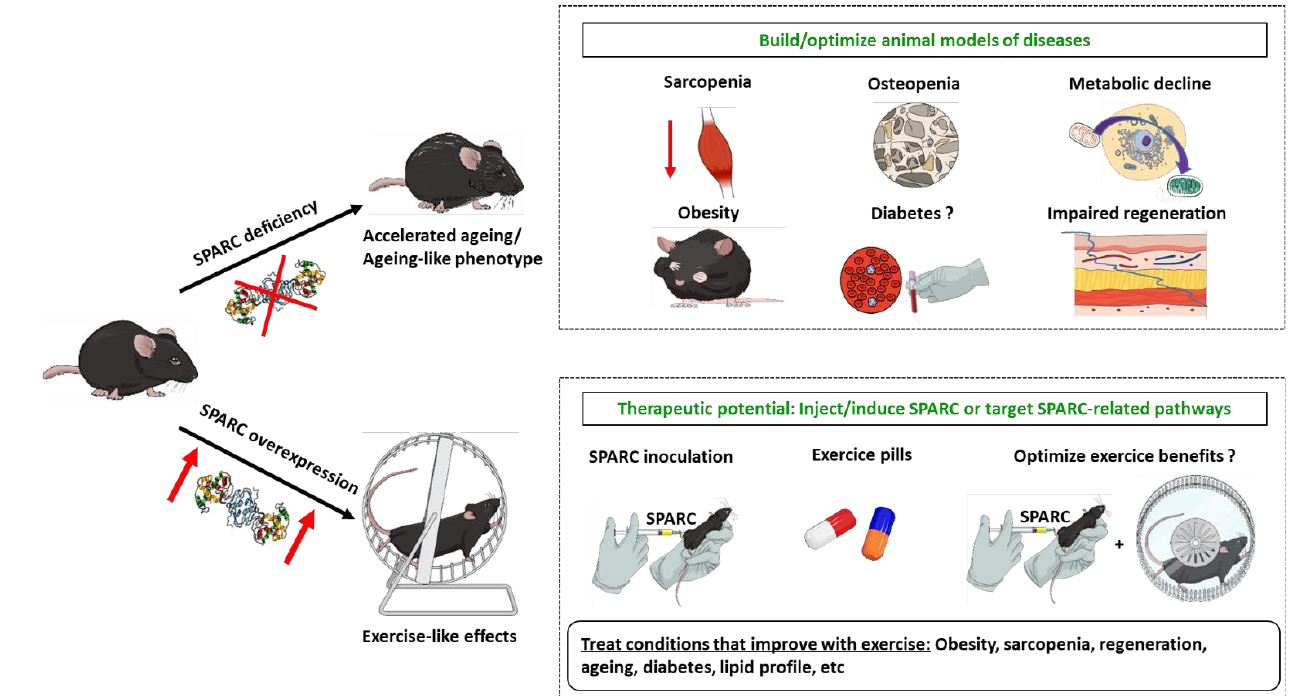
Figure 9. SPARC deficiency and ageing share similar phenotypes which are counteracted/improved by SPARC induction that mimics exercise effects. These can be exploited to both build/optimize animal models and potentially develop therapies to treat conditions that have common patterns with the SPARC-deficiency-related biological and functional changes. Abbreviations: SPARC, secreted protein acidic and rich in cysteine.